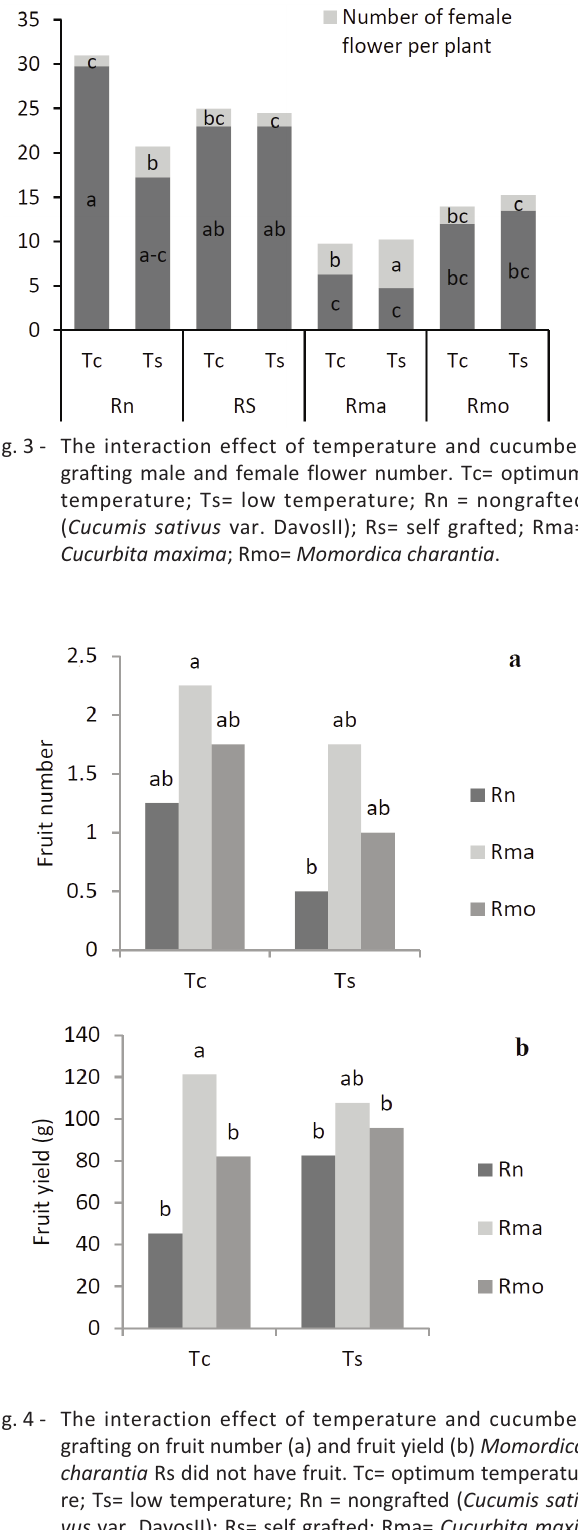
Fig. 6 ­ The interaction effect of temperature and cucumber grafting on average fruit weight and fruit diameter. Tc= optimum temperature; Ts= low temperature; Rn = non­ grafted ( Cucumis sativus var. DavosII); Rs= self grafted; Rma= Cucurbita maxima ; Rmo= Momordica charantia